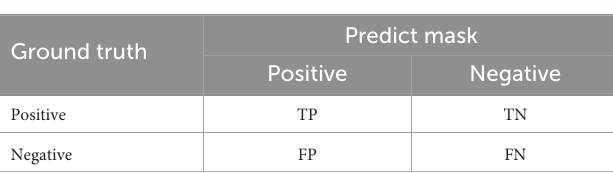
TABLE 2 Confusion